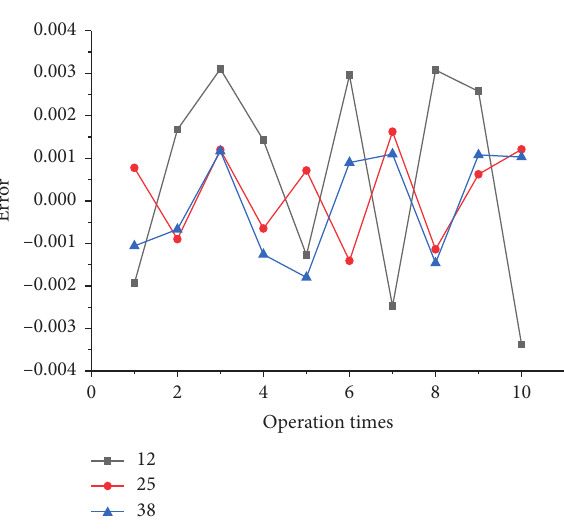
Figure 9: Error of